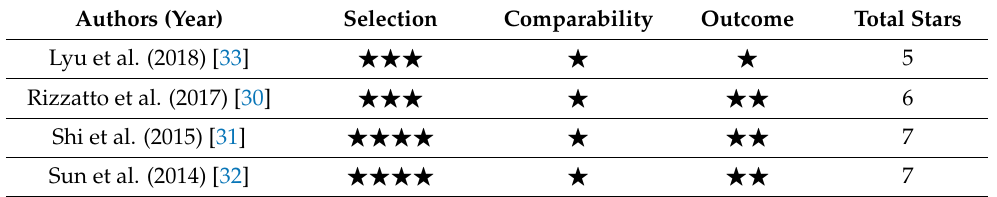
Table 4. Quality assessment of the included studies according to Newcastle-Ottawa Scale